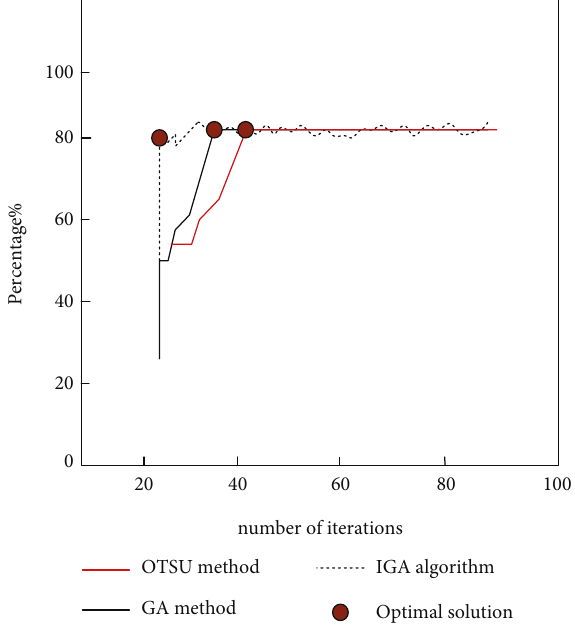
Figure 6: Adaptability of the three